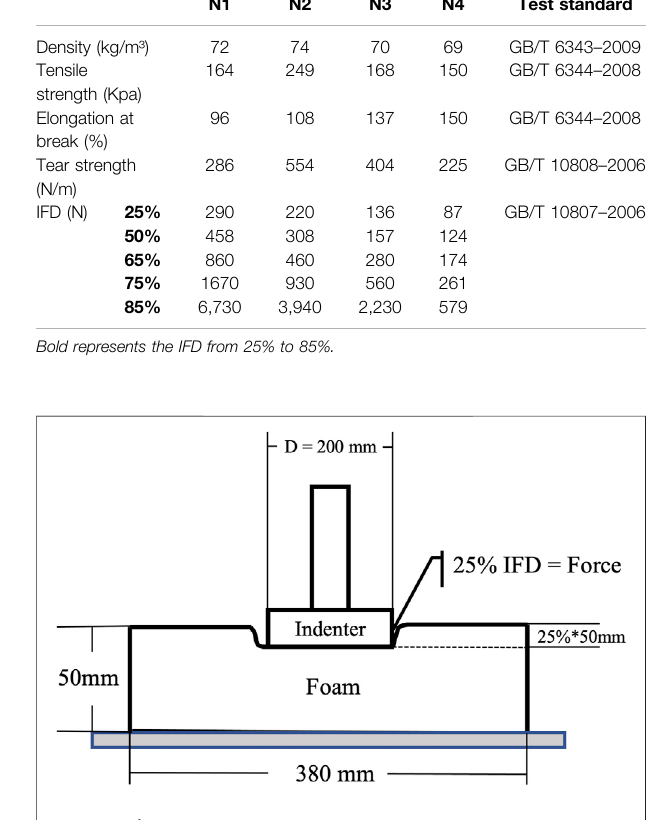
FIGURE 1 | The schematic of IFD